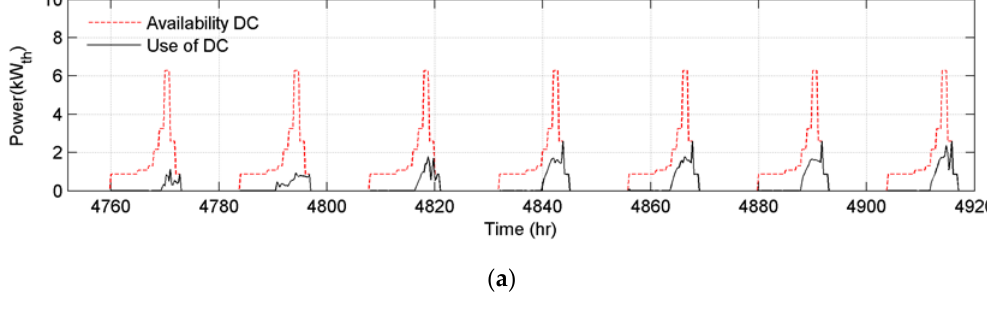
Figure 14. Comparison between actual indoor air temperature ( T air ) and its prediction in the MPC with OF C and PH of 18 h.